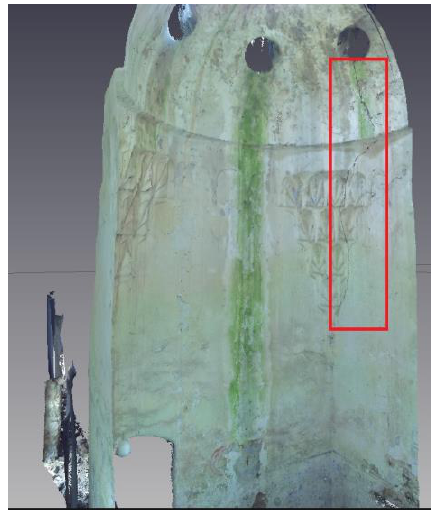
Figure 6. Wall part that contains complex surfaces and decorative motifs. The red rectangle indicates the crack